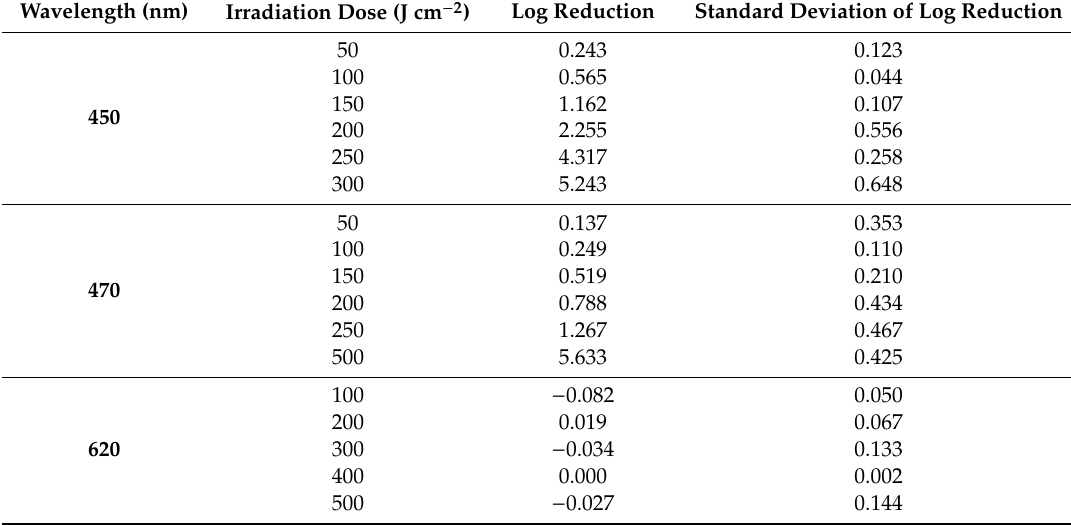
Table 1. Applied irradiation doses, log reduction, and calculated standard deviation of the log reduction for 450, 470, and 620 nm